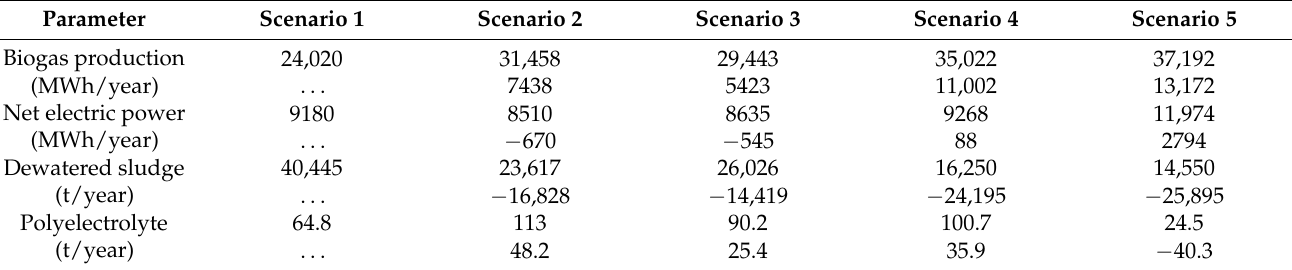
Table 9. Results obtained annually and used for the calculation of cash-flow parameters under Case I. The second row corresponds to the increment obtained when compared with Scenario 1. A negative sign represents a